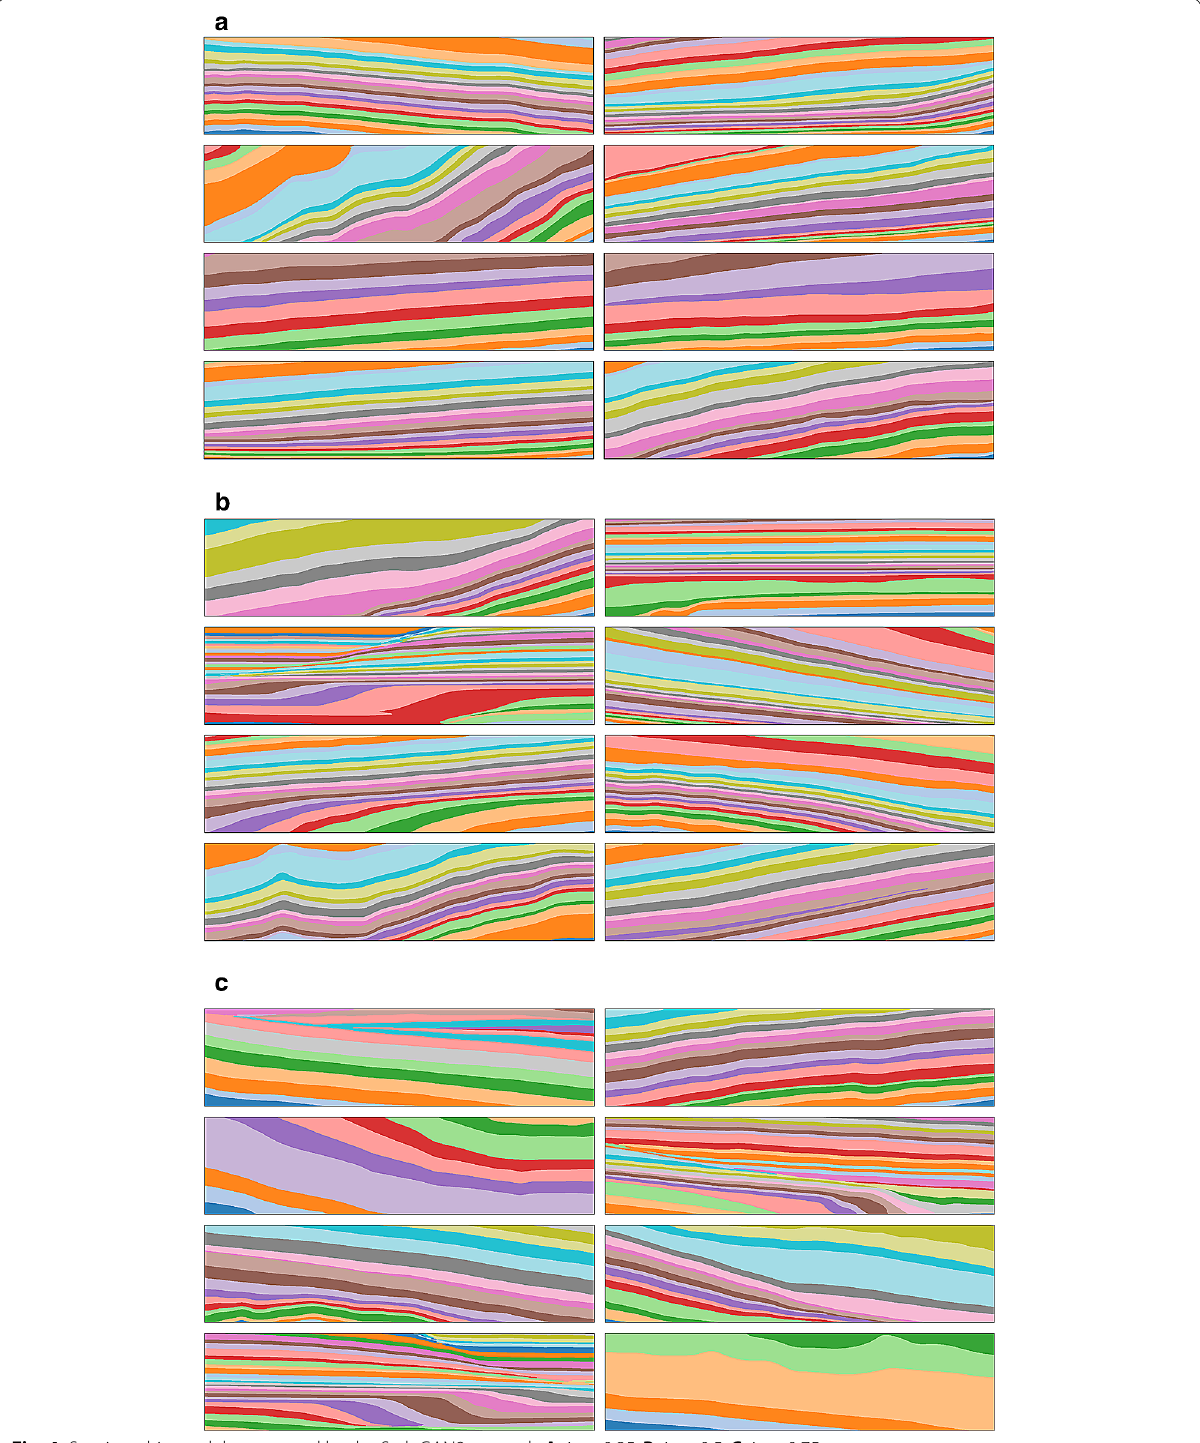
Fig. 4 Stratigraphic models generated by the StyleGAN2 network. A ψ = 0.25 . B ψ = 0.5 . C ψ =